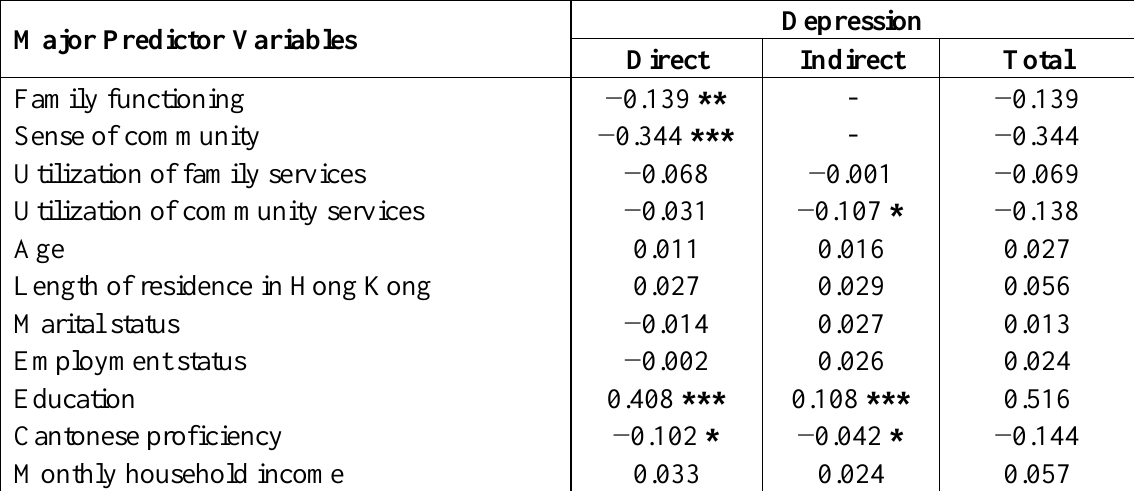
Table 2. Standardized direct, indirect, and total effects of major predictor variables on immigrant women’s